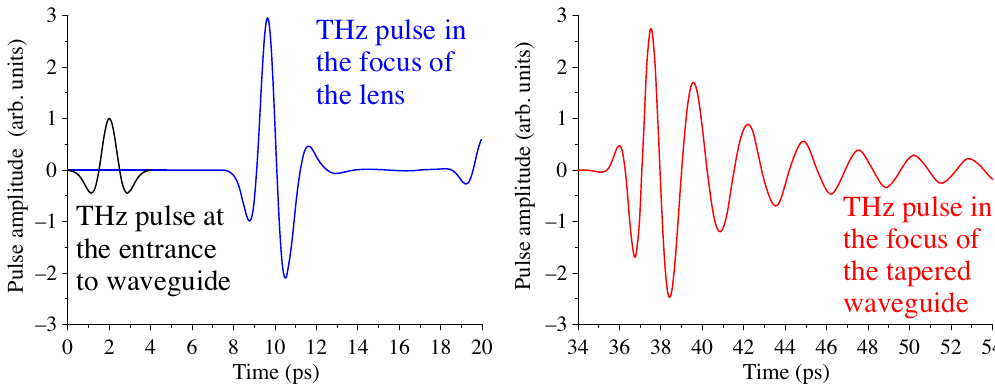
FIG. 7. Time structure of the initial THz pulse (black), the electric field at the focus of the lens (blue), and the electric field in the center of the tapered waveguide (red) for optimal focusing parameters, L ¼ 5 , d ¼ 0 . 4 mm. Both plots are on the same time scale (20 ps) and are normalized to the amplitude of the incoming THz pulse.